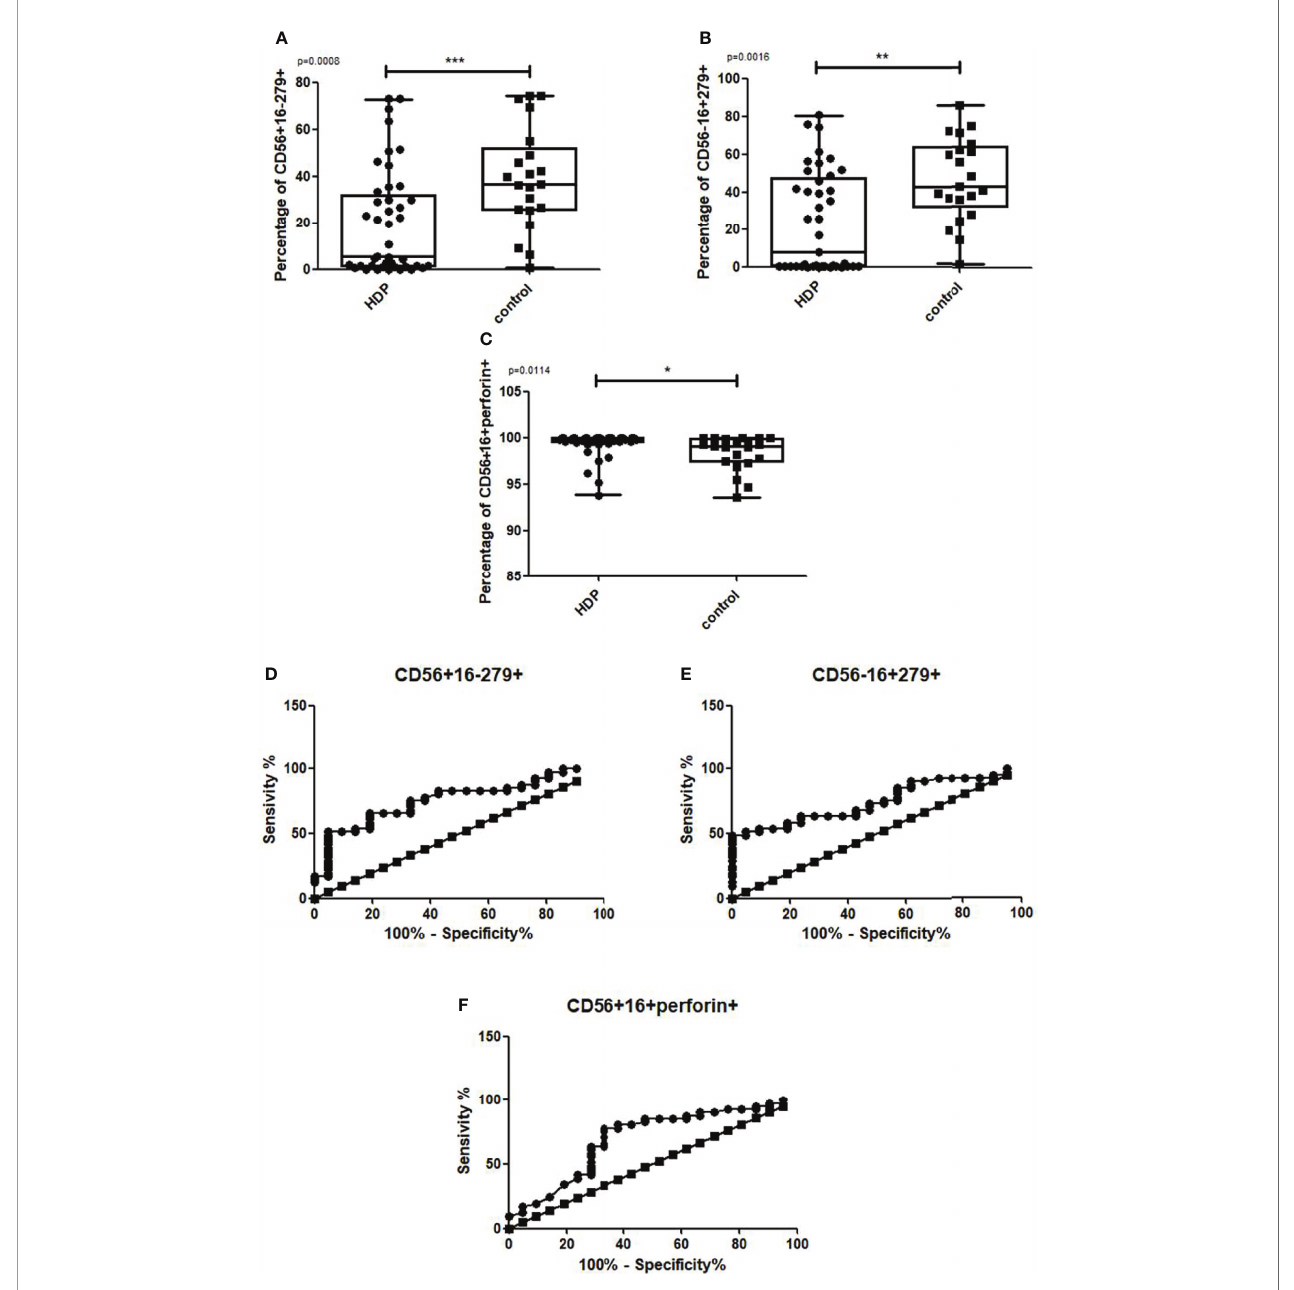
FIGURE 7 | Box and whiskers graphs and ROC curves presenting statistically signi fi cant parameters that differ between the HDP and the control group. CD279 on CD56+16-, CD56-16+ and perforin in CD56+16+ NK cells. Statistics performed with the U Mann Whitney test,